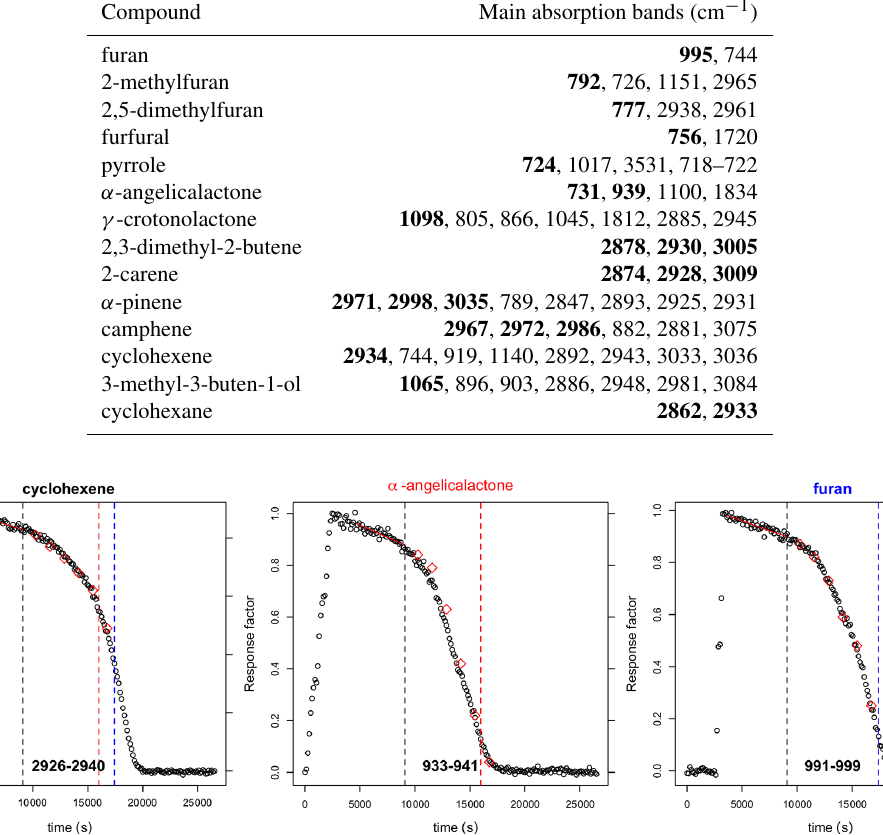
Figure 1. Concentration–time profiles from experiment with cyclohexene, α -angelicalactone, and furan. Black circles are response factors generated by the ANIR curve-fitting program relative to the reference spectra. Red diamonds are obtained from manual subtractions. The left black dashed vertical line is the beginning of the region used for the relative rate calculation, the red dashed line is the end of the region used for the calculation of the α -angelicalactone relative rate, and the blue line is the end of the region used for the calculation of the furan relative rate. Bold values at the bottom are the absorption bands used for analysis.